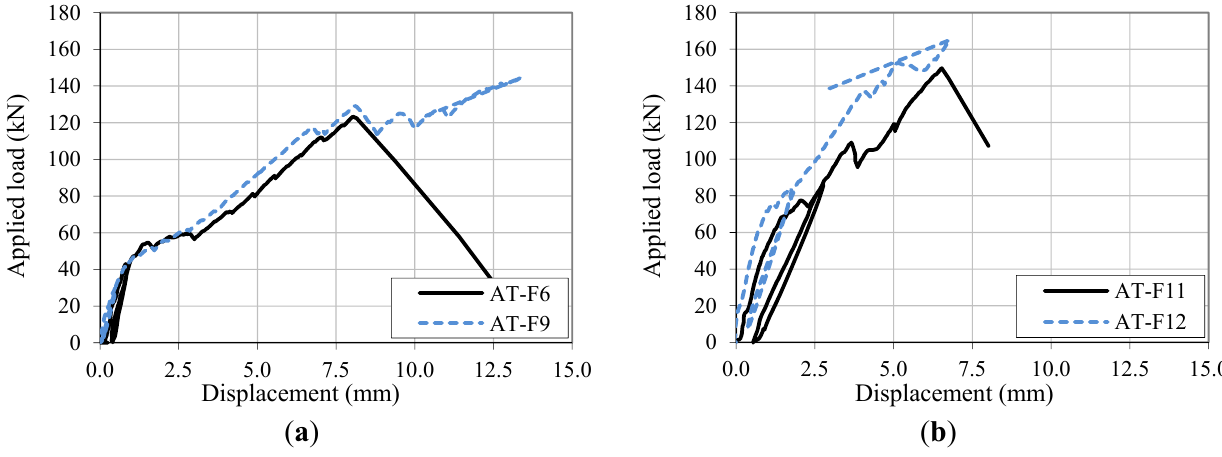
Figure 11. Comparison of measured fiber stress (strain gauges) and total stress ( F / A